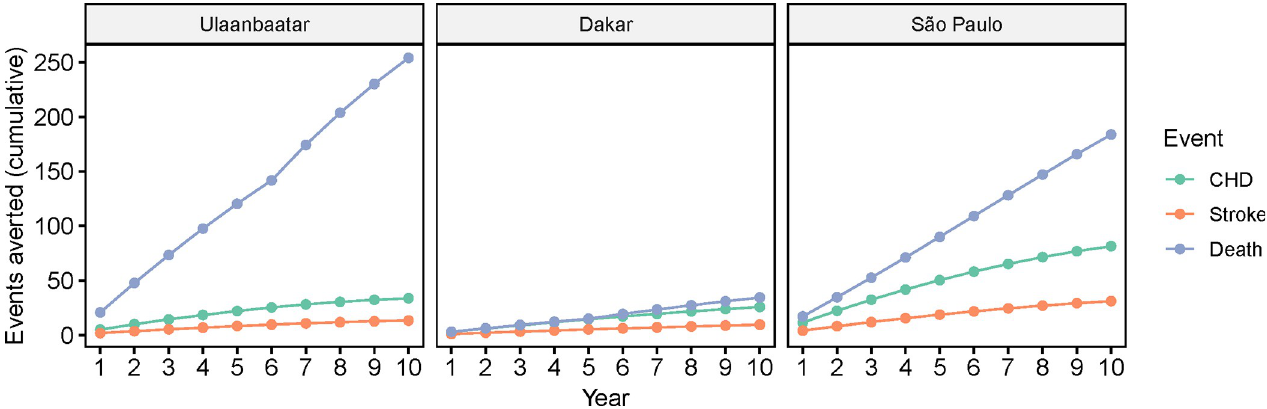
Fig 2. Estimated cumulative number of CV events and deaths averted 10 years after CARDIO implementation.